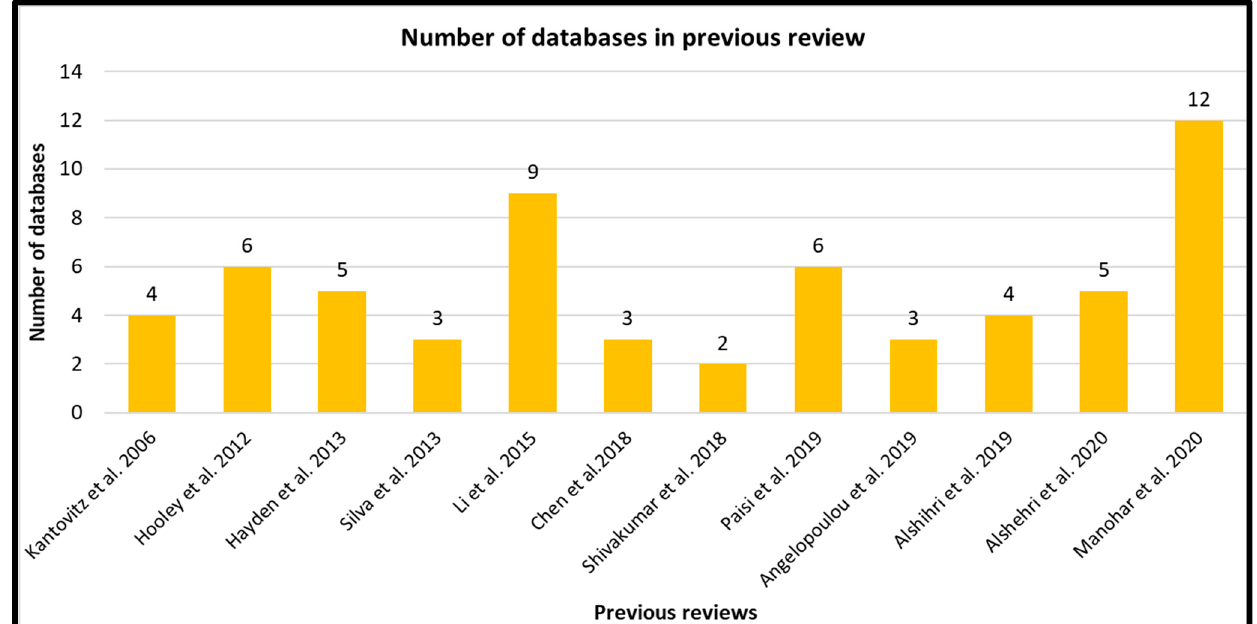
Figure 2. Number of databases used in previous systematic reviews.